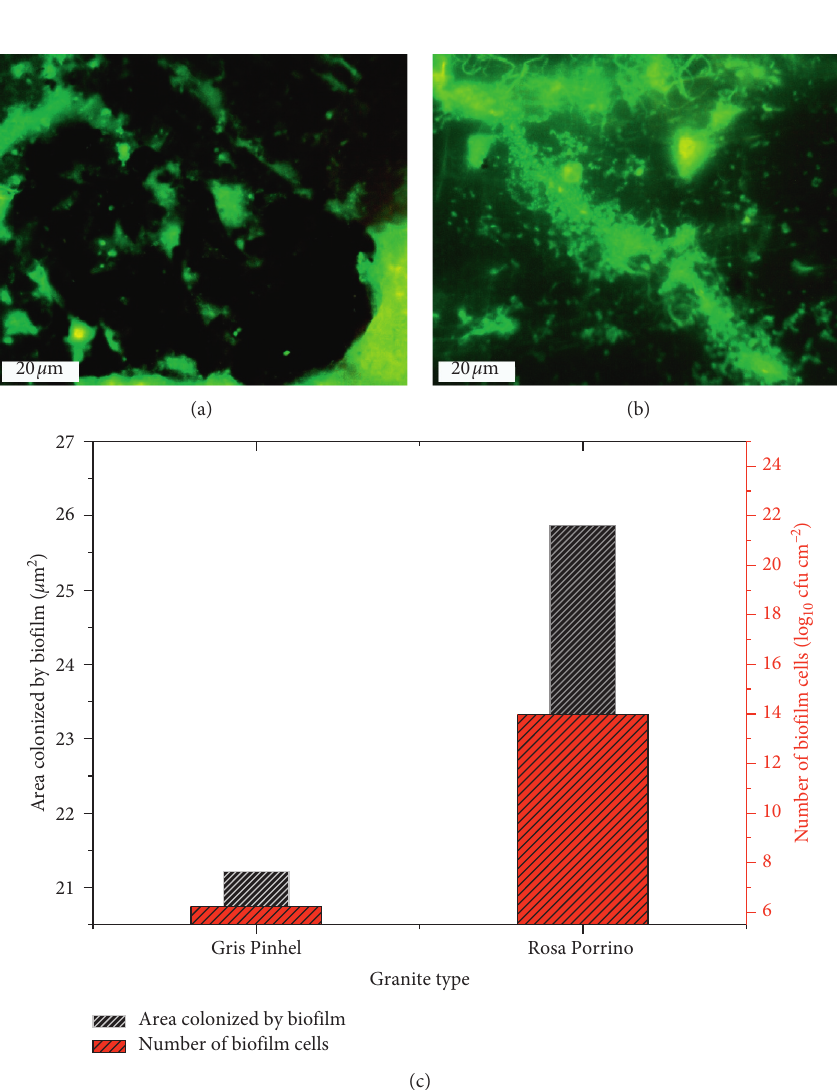
Figure 6: P. aeruginosa biofilm formation on the Gris Pinhel (a) and Rosa Porrino (b). (c) Number of biofilm cells (red bar) and the percentage of the area colonized by P. aeruginosa biofilm on surfaces (black bar) on granite Rosa Porrino and granite Gris